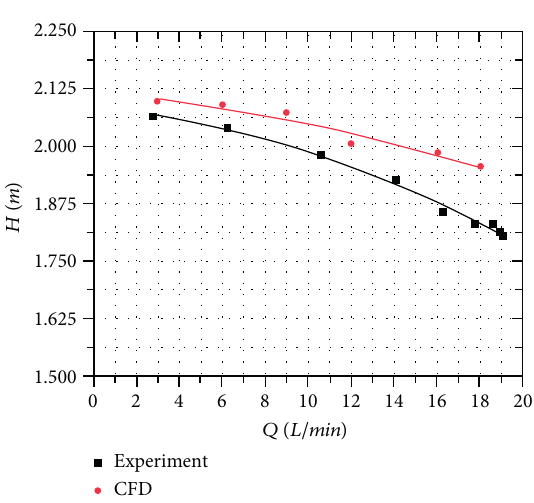
Figure 10: Comparison of performance curves between CFD and experimental